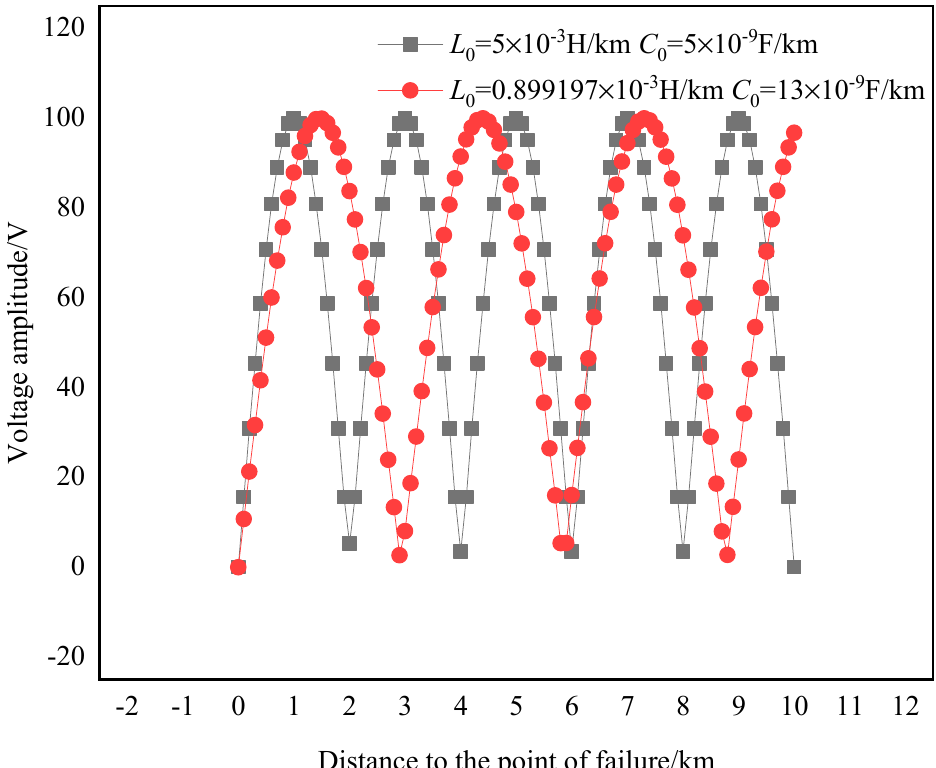
Figure 4. The standing wave voltage amplitude of different R 0 and C 0 values varies periodically along the line.